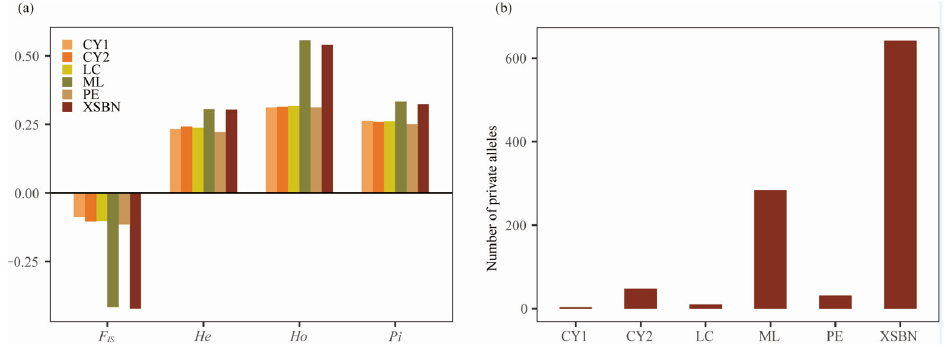
Figure 3. The results for the diversity parameters of T. doichangensis populations. ( a ) Expected heterozygosity ( He ), observed heterozygosity ( Ho ), inbreeding coefficient ( F IS ) and nucleotide polymorphism ( Pi ); ( b ) number of private alleles (PAs). The values of F ST ranged from 0.0462 to 0.1402 (Table 3, Figure 4a) with an average of 0.0921, and the average Nm = (1 − F ST )/4 ∗ F ST = 2.7194. The results showed that there was genetic differentiation and gene flow between populations. In addition, the CY1 and CY2 populations showed the lowest F ST ( F ST = 0.0462) and the ML and XSBN populations showed the largest F ST ( F ST = 0.1402), indicating that only 4.62% of the variation occurred between the CY1 and CY2 populations and most (95.38%) occurred within populations. CY1 and CY2 were geographically closest and in the same region (Figure 1; Table 3), which may also have been the reason for the low genetic differentiation between CY1 and CY2. However, after we analyzed the correlation between genetic distance and geographic dis ‐ tance, we found that there was no significant correlation between genetic distance and geographic distance (Figure 4b). The AMOVA results also indicated that variation oc ‐ curred within populations rather than among populations (Table 4). Table 3. Genetic distance and geographic distance between populations of T. doichangensis . Below diagonal: genetic distance among populations ( F ST ). Above diagonal: geographic distance between populations (km). Populations